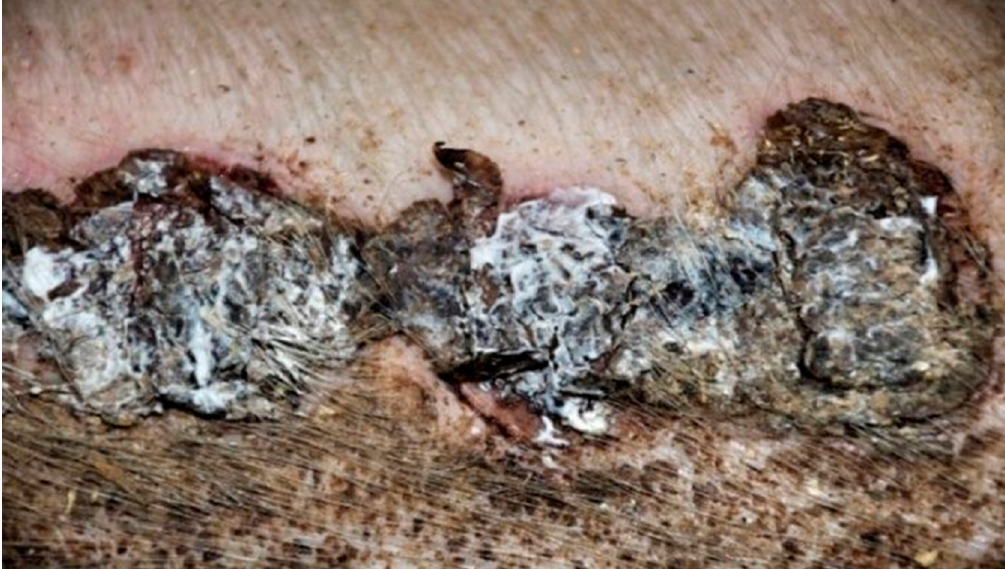
Figure 8. Group K—burn wound treated with sulfathiazole on day 15.